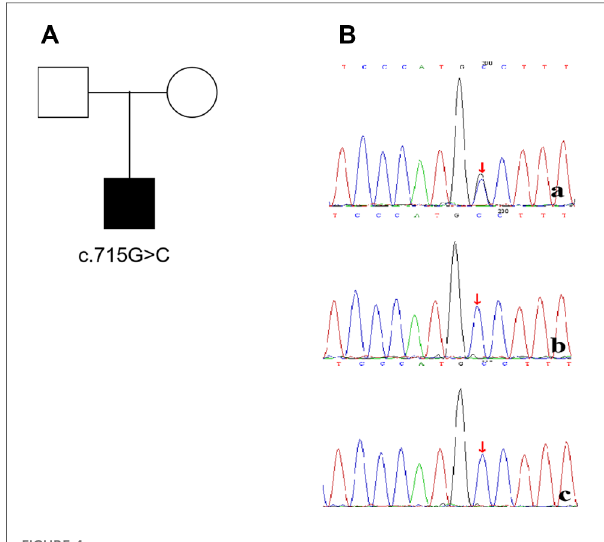
FIGURE 4 The child( a ) has a de novo mutation (c.715G>C,p.A239P), his father( b ) and mother( c ) have no mutation at the same